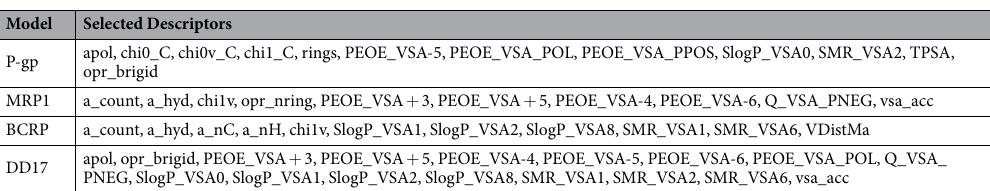
Table 2. Descriptors reported by Demel et al . 16 for the binary classification of P-gp, MRP1 and BCRP substrates. A total of 17 descriptors with Pearson’s correlation coefficient lower than 0.9 were identified from all models and they were joined into the DD17